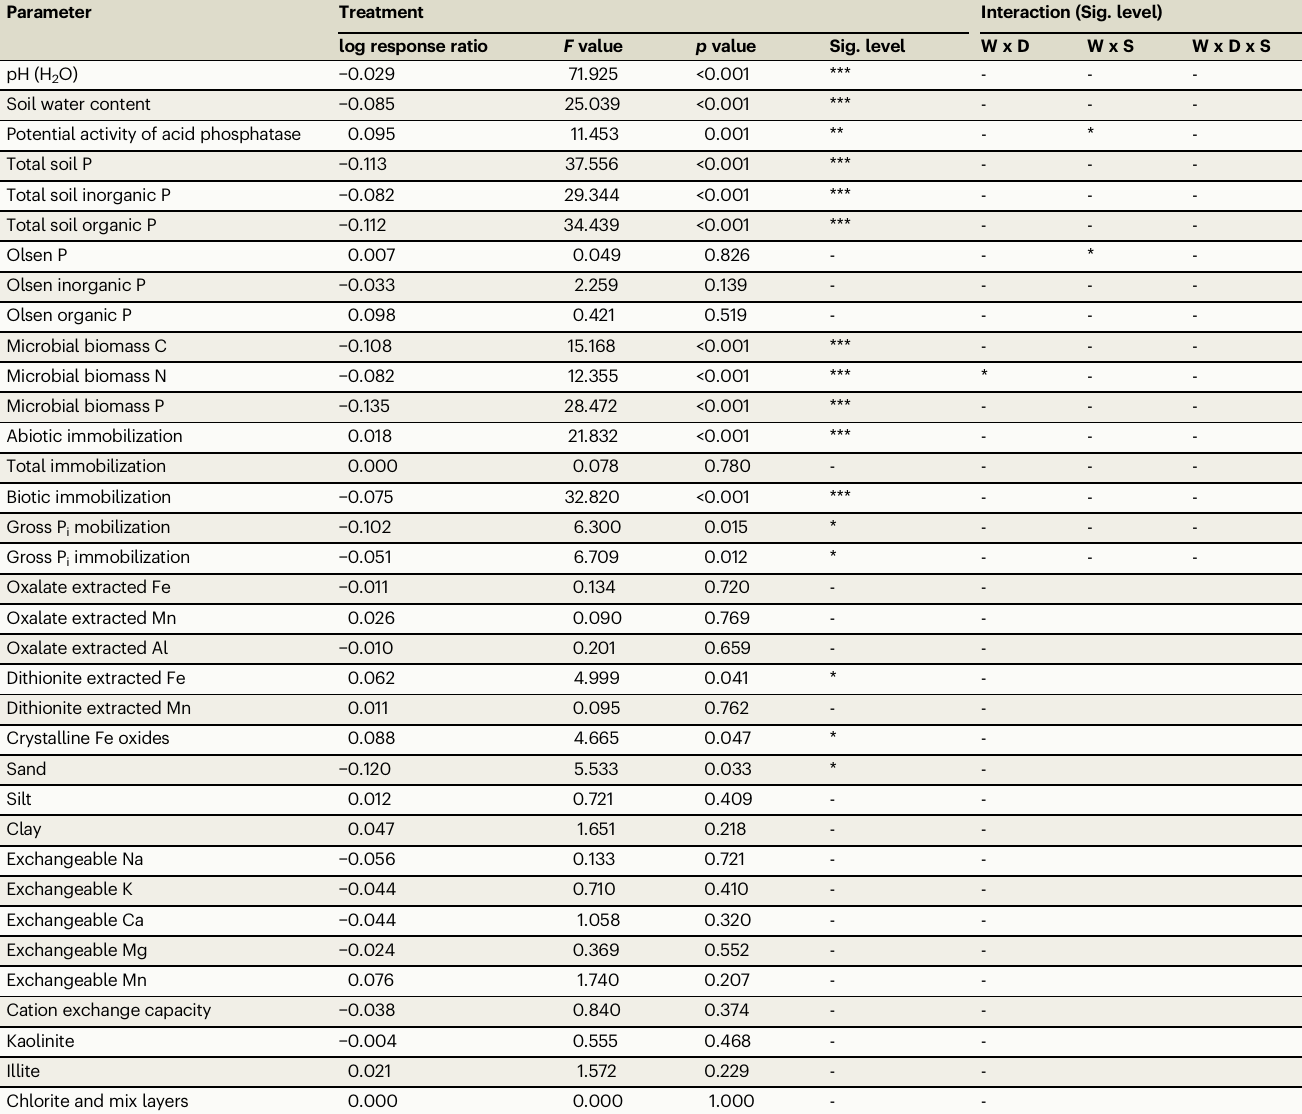
Table 2 | Results of mixed-effects models with warming (W), soil depth (D), and season (S; for seasonal data) as fi xed factors, block and warming duration as random factors, including interactive effects between main factors (seasonal data: n = 72;